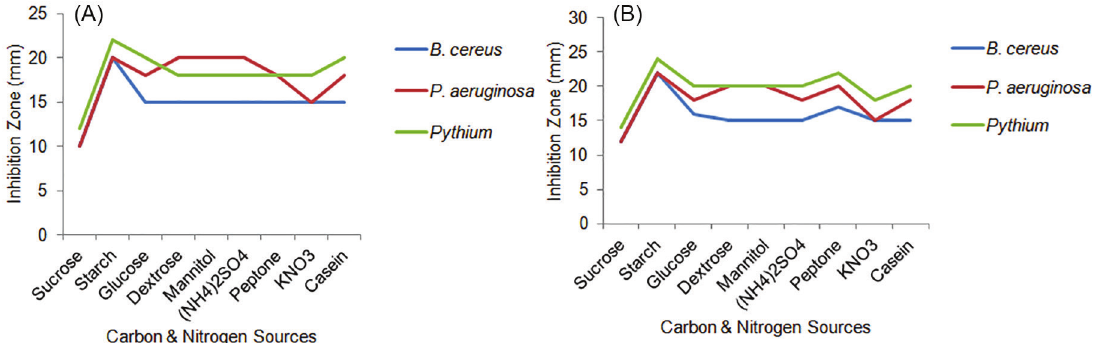
FIGURE 2 - Antimicrobial activity of the bacterial endophytes against B. cereus , P. aeruginosa , and Pythium at different incubation periods (A) B. amyloliquefaciens DSM7 (B) B. subtilis subsp. subtilis str. 168